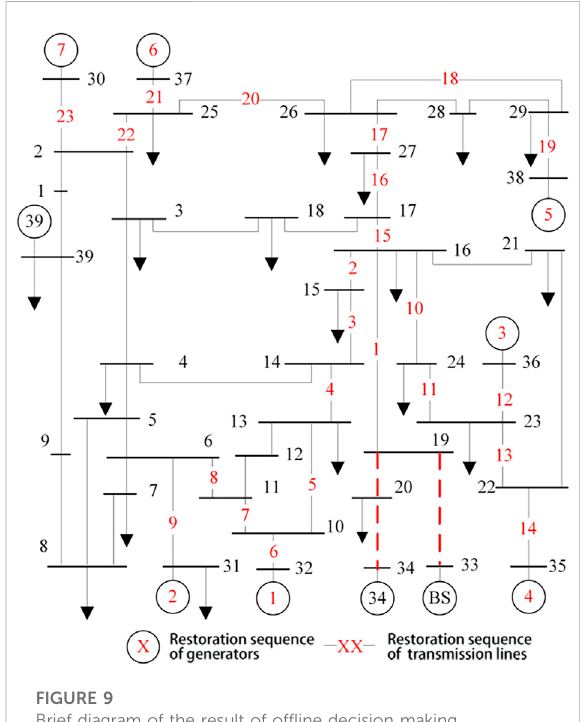
FIGURE 9 Brief diagram of the result of of fl ine decision